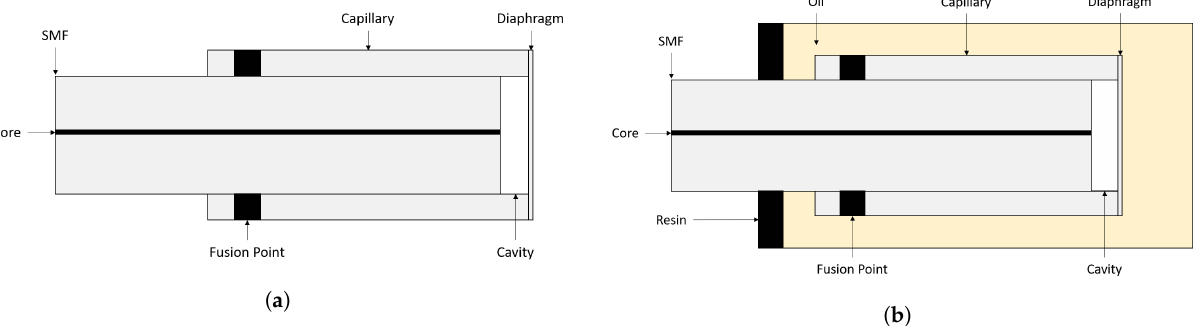
Figure 1. ( a ) Schematic of OFPS sensor based on McGuinness et al. (Adapted from ref. [16]). ( b ) Schematic of UHRTS sensor based on Poeggel et al. (Adapted from ref. [15]).